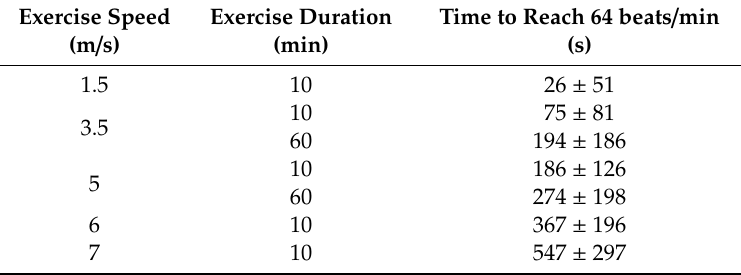
Table 4. Time when the heart rate of 64 beats / minute was reached by the horses after exercise at di ff erent speeds for 10 and 60 min duration (mean ± SD; seven